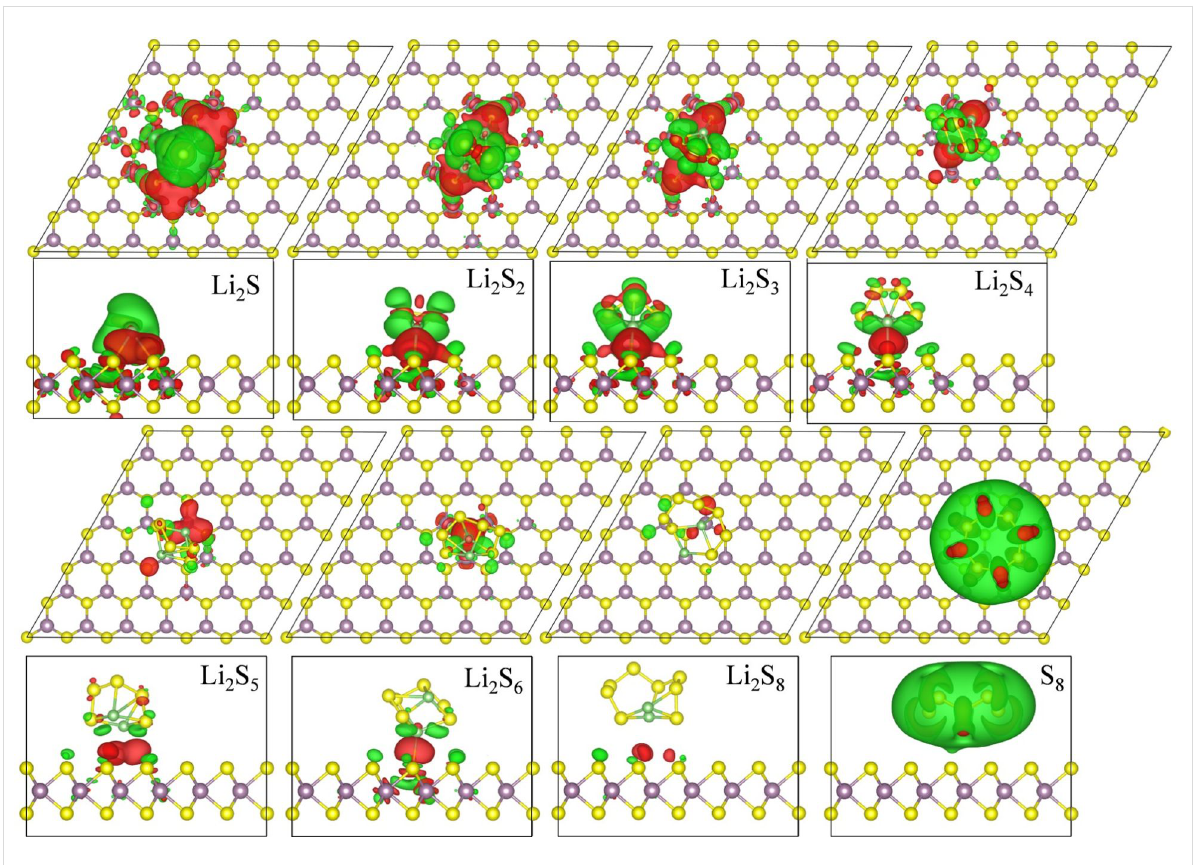
Figure 3: Isosurface (0.0005 e/Å 3 ) of the charge distributions of Li 2 S x absorbed on 2H-MoS 2 monolayer. The red and green surfaces correspond to charge gain and loss, respectively.